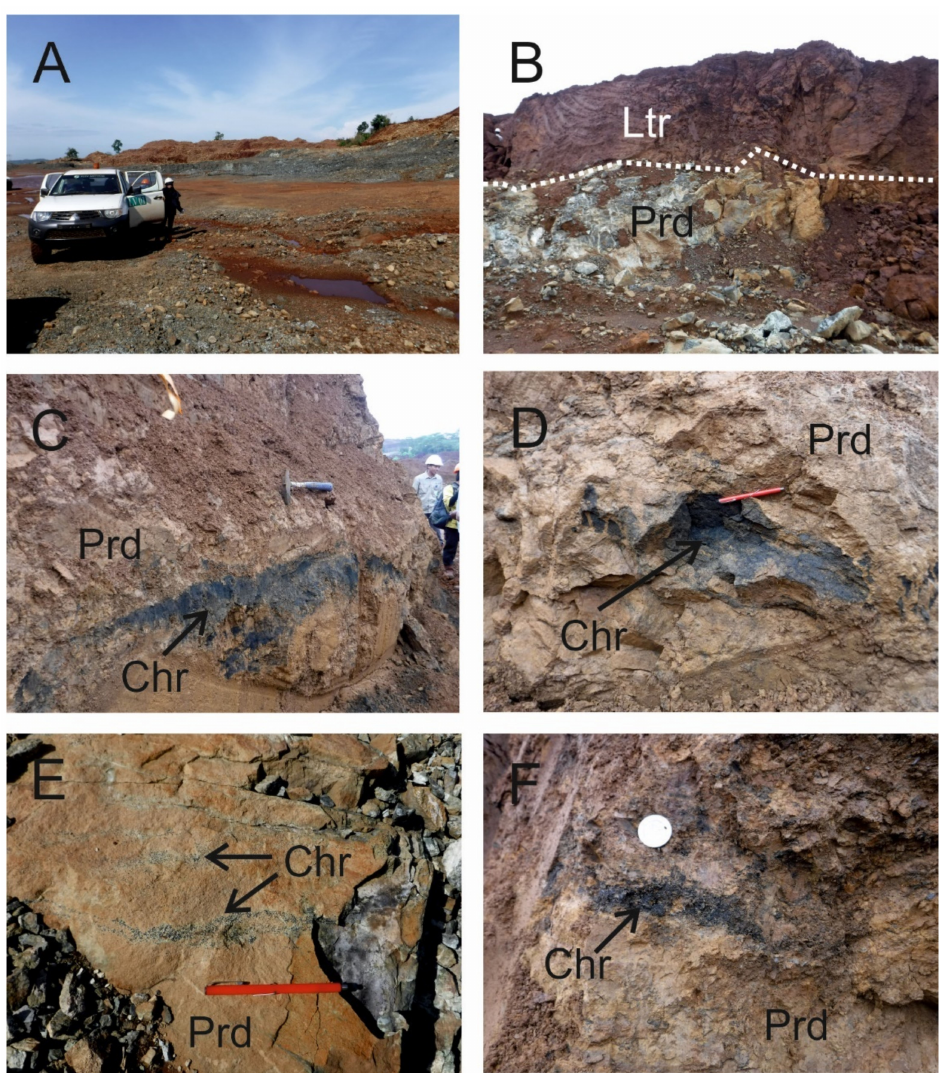
Figure 3. General overview of selected outcrops of the studied chromitites in Sebuku Island: ( A ) field image of weathered peridotite which hosts the chromitites, ( B ) lateritic horizon of bedrock peridotite, ( C ) schlieren of massive chromitite, ( D ) pod of massive chromitite, ( E ) thin layered and disseminated chromitites and ( F ) small pocket of massive chromitite within weathered peridotite. Abbreviations: Chr—chromitite, Lrt—laterite, Prd—weathered and altered